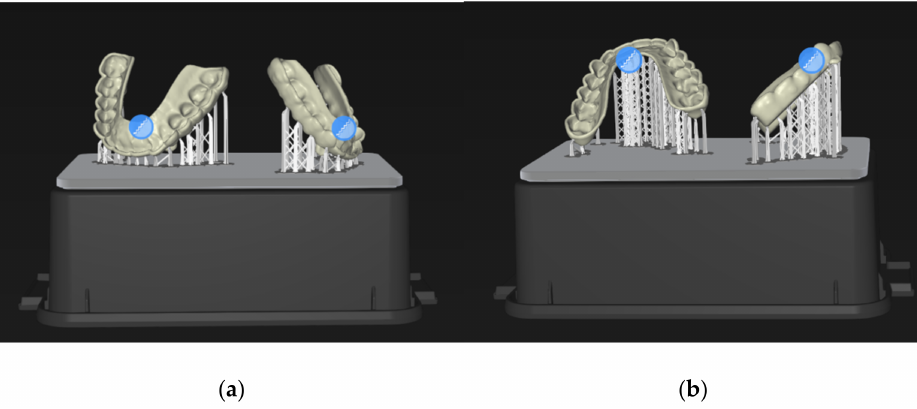
Figure 4. Orientations of the occlusal devices on the building platform ( a ) 2.5 ( b )